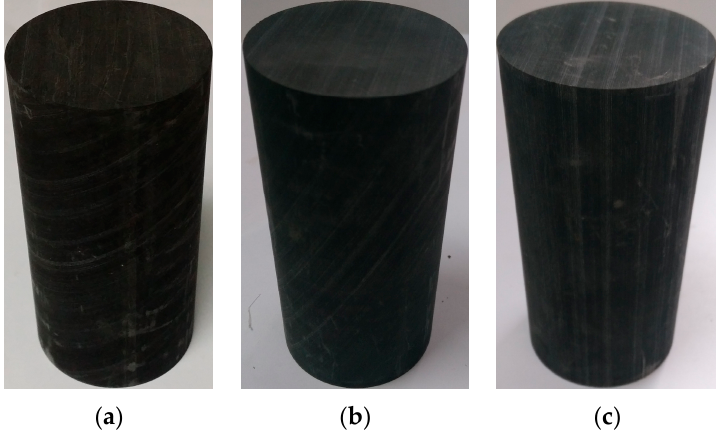
Figure 2. Shale-5 samples with different oriented weak planes. ( a ) β = 30 °; ( b ) β = 60 °; and ( c ) β = 90 °. Table 3. Basic physical and mechanical properties of Shale-5 samples.